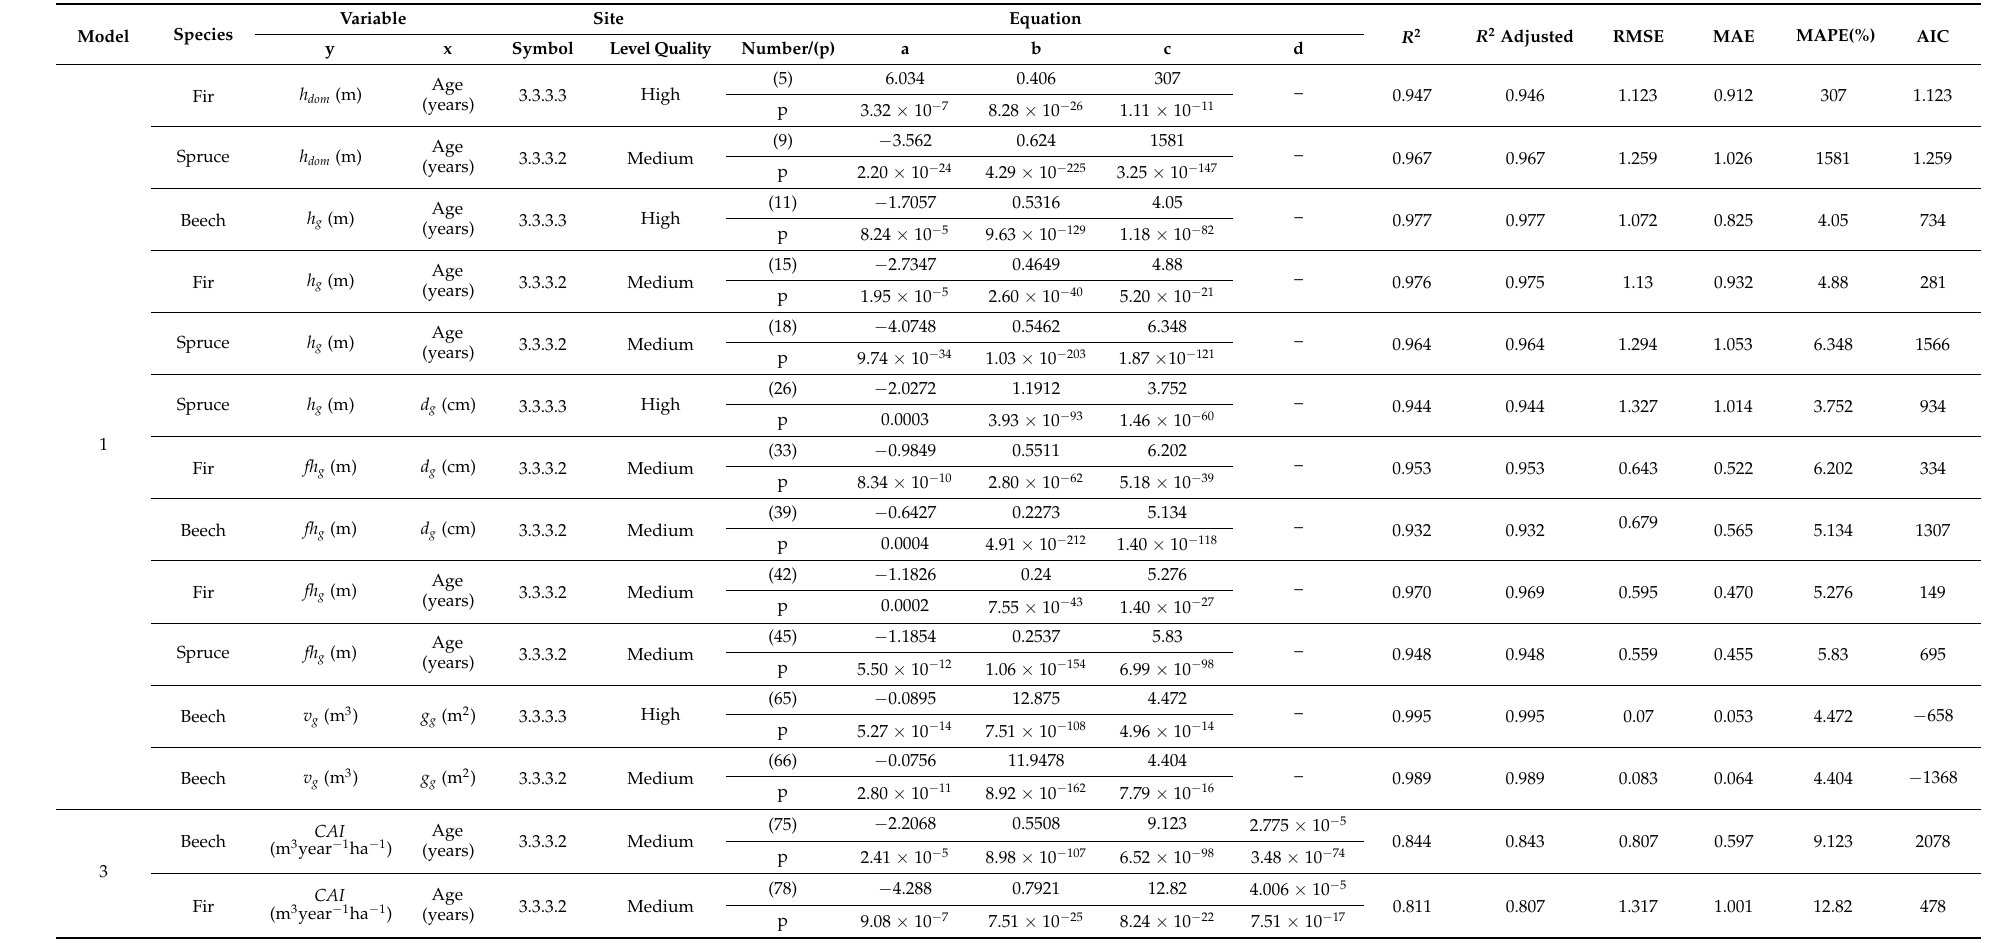
Table 4. Statistical descriptors of